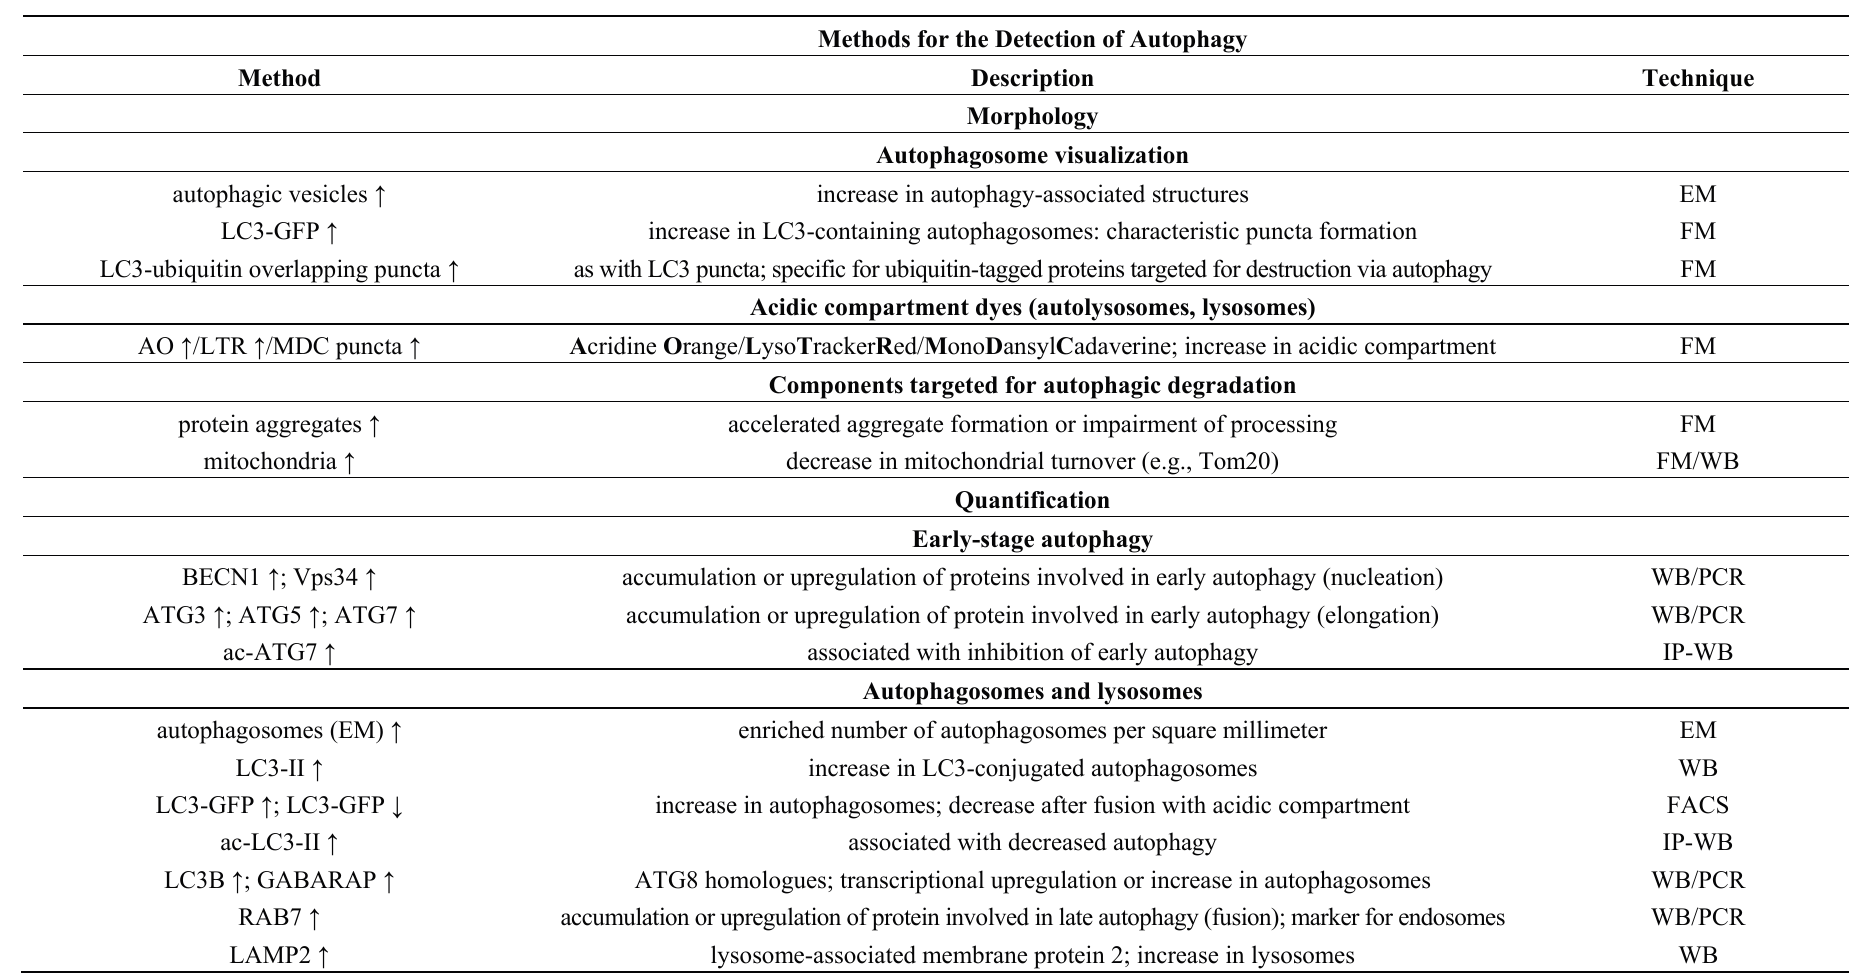
Table 1. Methods for the detection of autophagy. EM—electron microscopy; FM—fluorescent microscopy; WB—Western blot; FACS—fluorescence-activated cell sorting; PCR—quantitative real-time polymerase chain reaction; IP—immunoprecipitation;